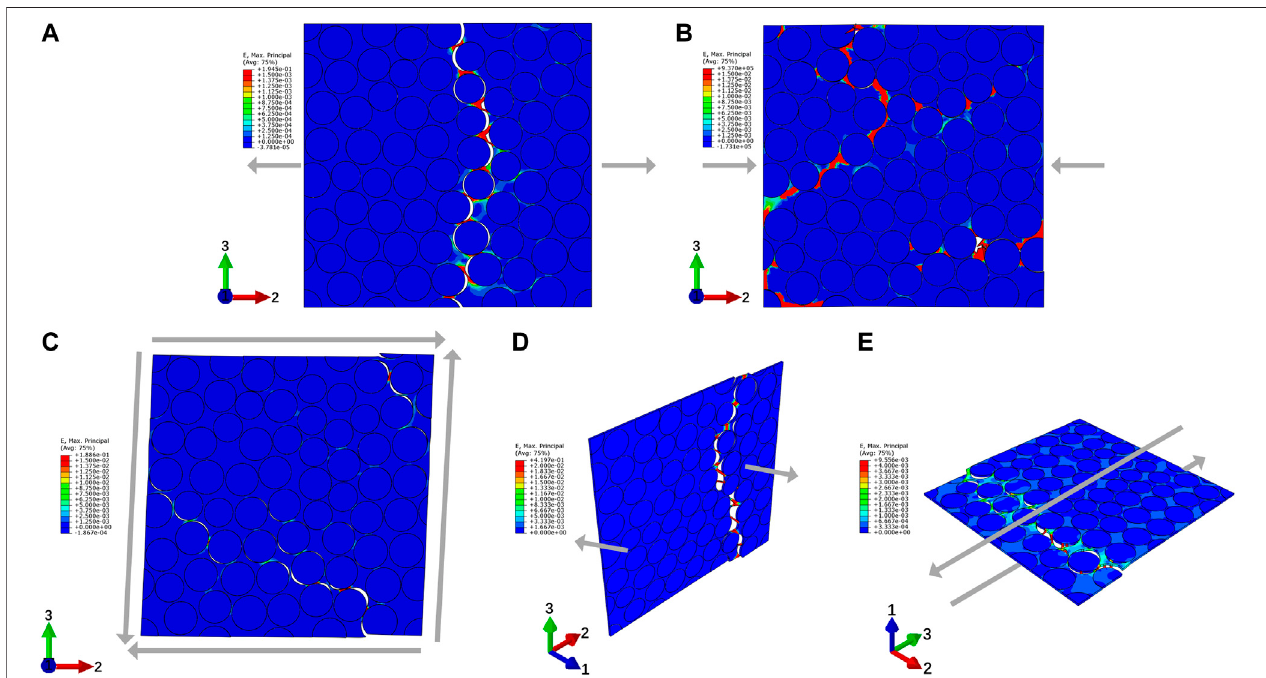
FIGURE 7 | Contour plots of the accumulated strain with different loading conditions when ceramic composite ( V f (cid:2) 70%) fails: (A) transverse tension with deformation magni fi ed by a factor of 10, (B) transverse compression, (C) out-plane shear ( τ 23 ) with deformation magni fi ed by a factor of 20, (D) in-plane parallel shear ( τ 12 ) with deformation magni fi ed by a factor of 50, and (E) in-plane perpendicular shear ( τ 21 ) with deformation magni fi ed by a factor of 100.